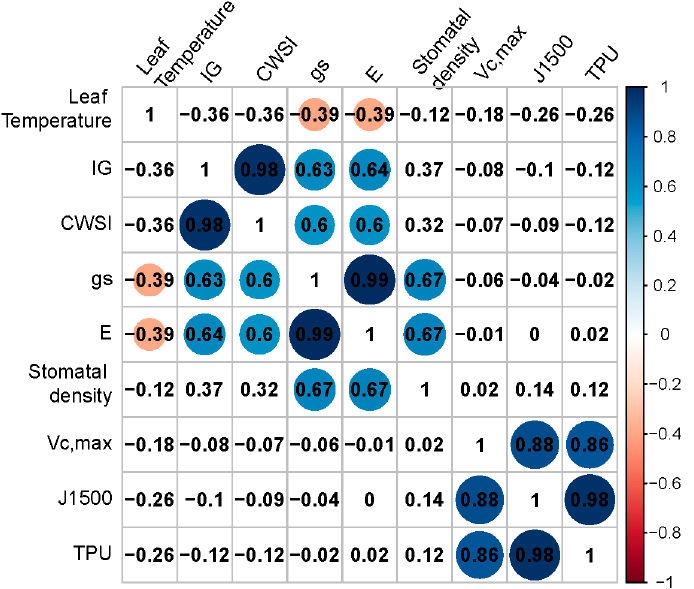
Figure 4. Correlation matrix between leaf temperature, thermal index (I G ), crop water stress index (CWSI), stomatal conductance ( g s ), transpiration rate ( E ), stomatal density, maximum carboxylation rate (V cmax ), electron transport rate at 1500 µmol m − 2 s − 1 (J 1500 ) and maximum triose phosphate utilization rate (TPU), across all experiments (4 experiments × 7 genotypes, hence n = 28). Numbers represent Pearson’s correlation coefficient; blue circles represent positive correlations ( p < 0.05) and red circles represent negative correlations ( p < 0.05). Size of circle depends on height of correlation, while in the cells without circle, no statistically significant correlations were found. Pearson’s correlation test was performed.